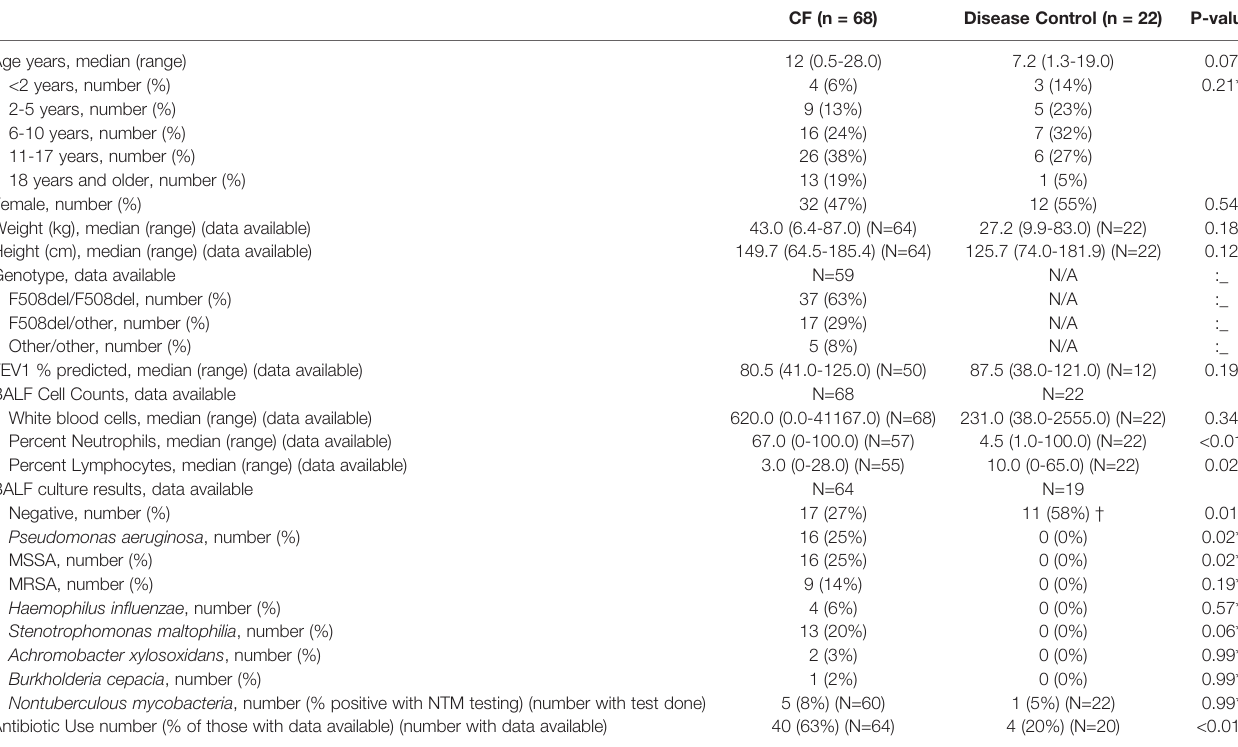
( Figure 2A ). Lysophosphatidylcholine (12:0) and acylcarnitine (0:0) concentrations were lower and L-methionine